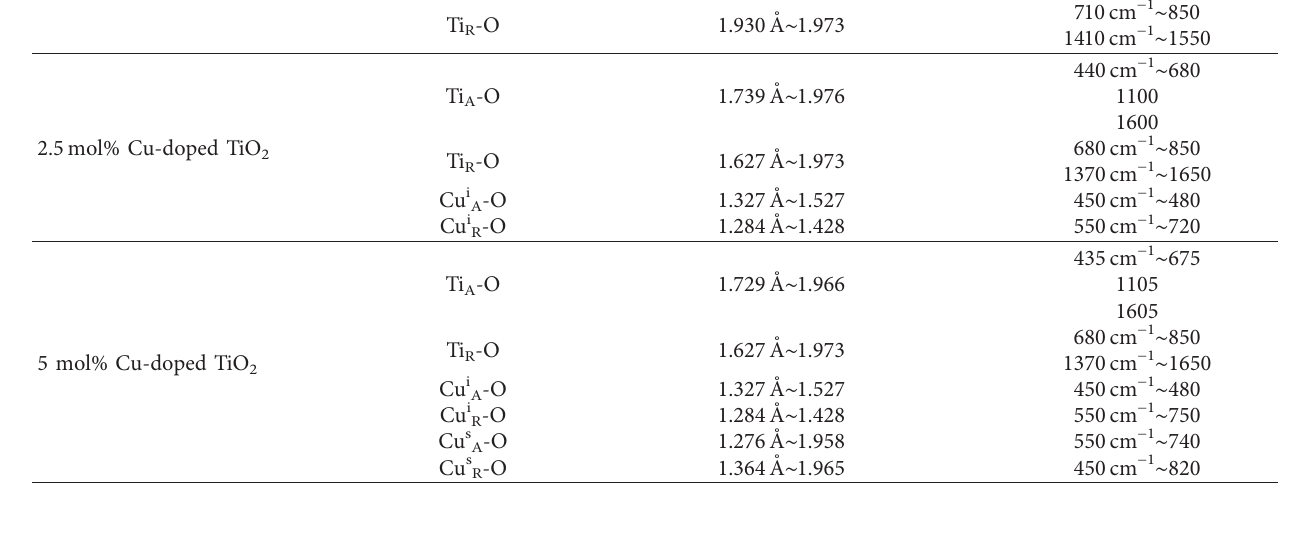
Table 3: The vibration frequency range corresponding to the various bonds of undoped and Cu-doped TiO Sample